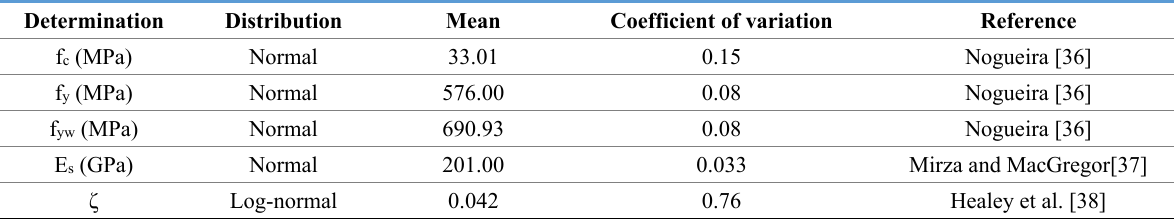
Table 1. Random variables